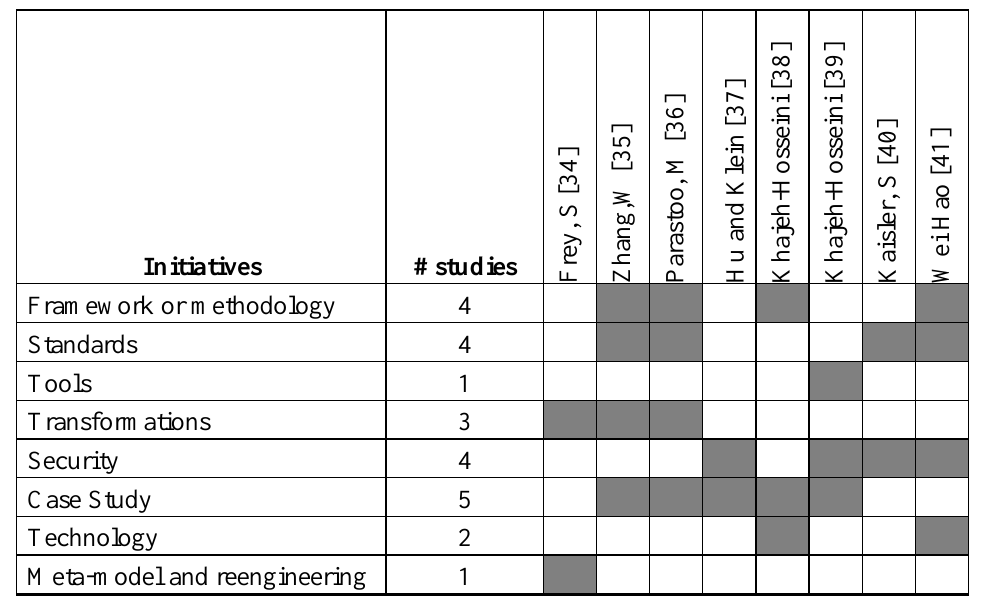
Table 1. Overview of studies per